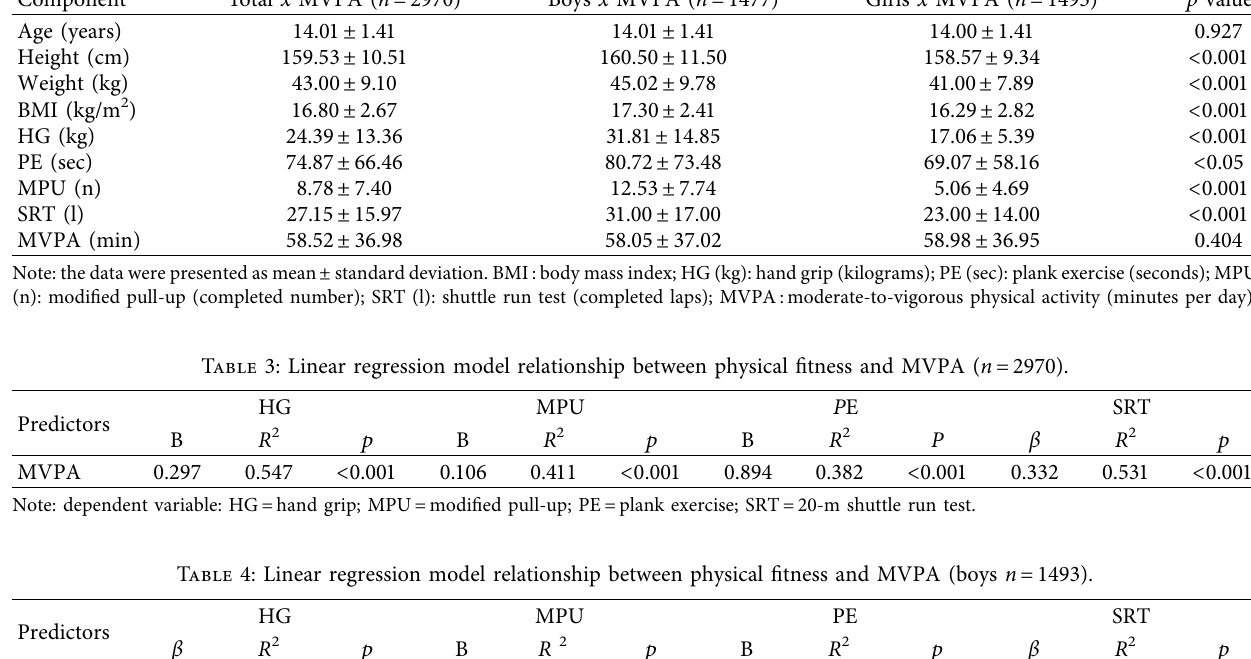
Table 2: Gender-specific descriptive analysis of anthropometric parameters, PF, and MVPA. Component